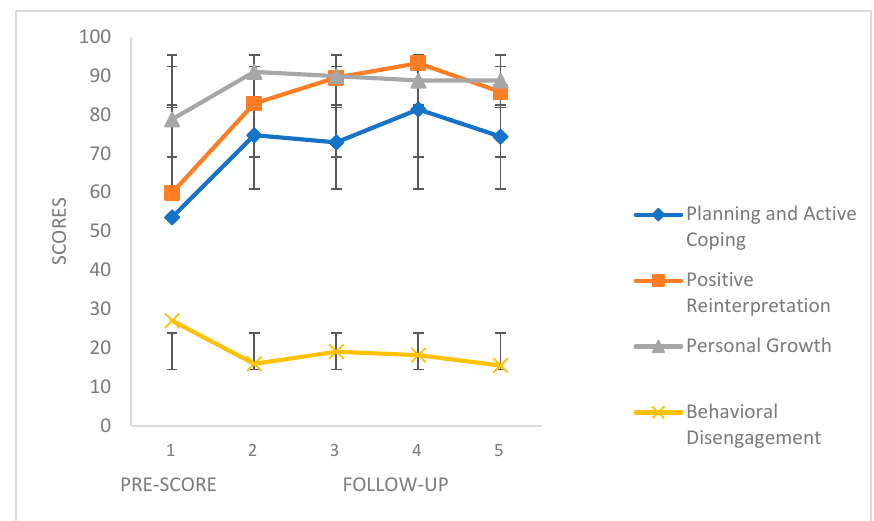
Figure 3 COPE variables in the follow-up. Mean values (SD). Figure 3. COPE variables in the follow-up. Mean values (SD).